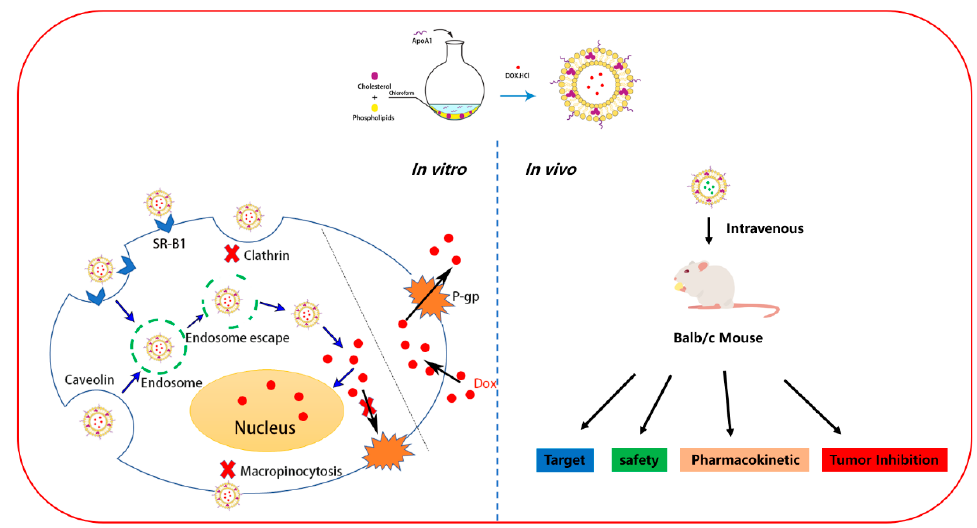
Figure 7. Schematic illustration of the preparation, the antitumor mechanism, and safety evaluation of ApoA1-lip/Dox.